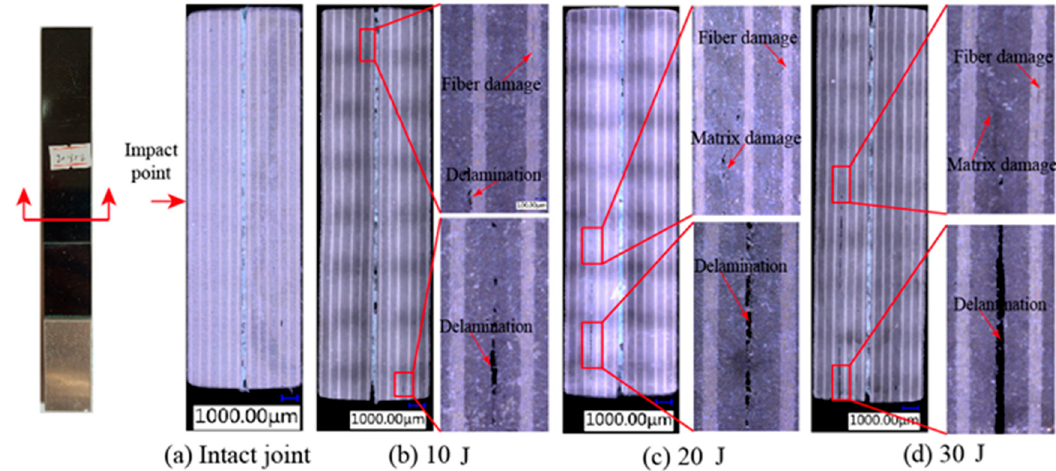
Figure 12. The microscopic damage of CFRP laminate SLJs at different impact energies: ( a ) Intact joint, ( b ) 10 J, ( c ) 20 J, ( d ) 30 J.